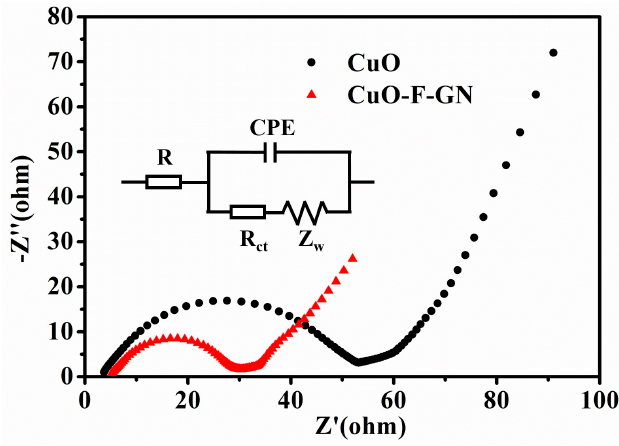
Figure 5. Nyquist plots of pure CuO and the CuO/f-graphene composite electrodes.